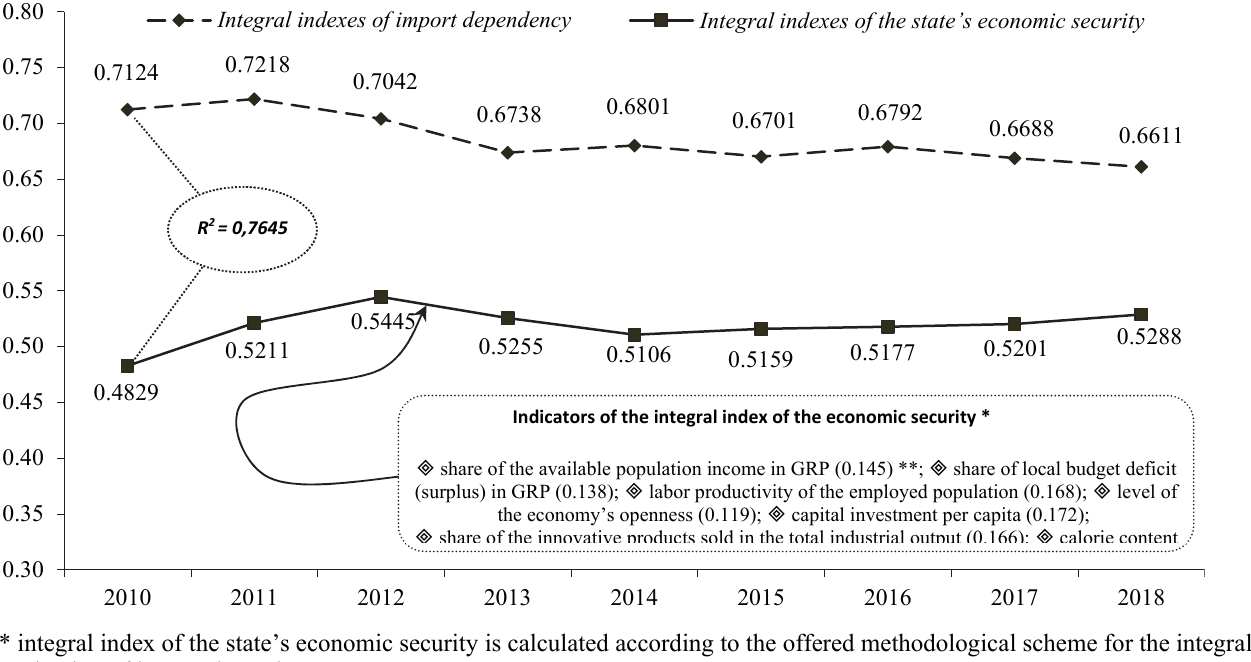
Fig. 2. Graphical interpretation of the integral indexes of import dependency and Ukraine’s economic security in 2010-2018